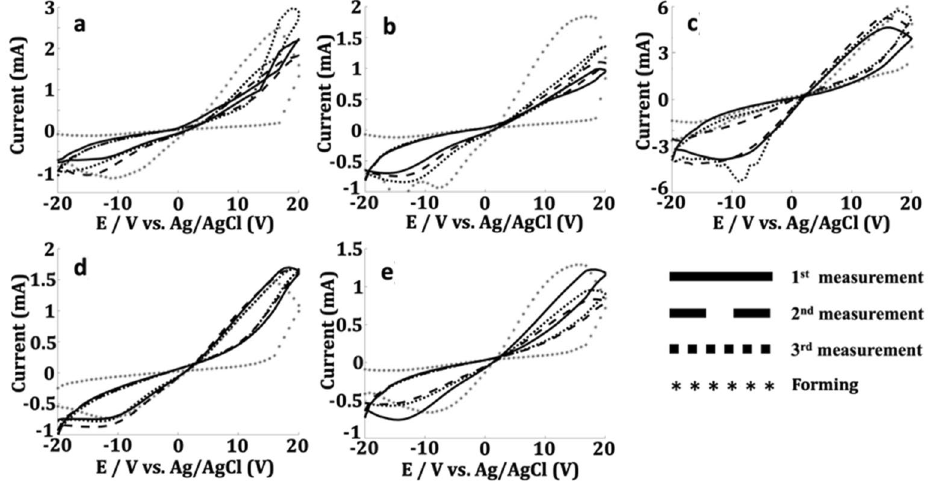
Figure 3. Output currents obtained by performing successive measurements using 0.7 mg dL −1 concentration of creatinine for ( a ) 1BOBzBT 2 :4CHCl 3 -sensor, ( b ) 1BOBzBT 2 :3CHCl 3 -sensor, ( c ) 1BOBzBT 2 :2CHCl 3 -sensor, ( d )